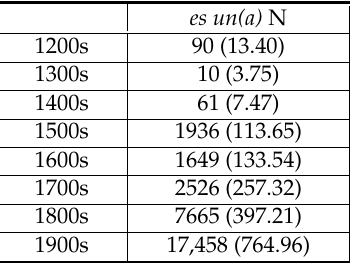
Table 3. The string es un(a) N in CdE (raw figures and frequency per million words).